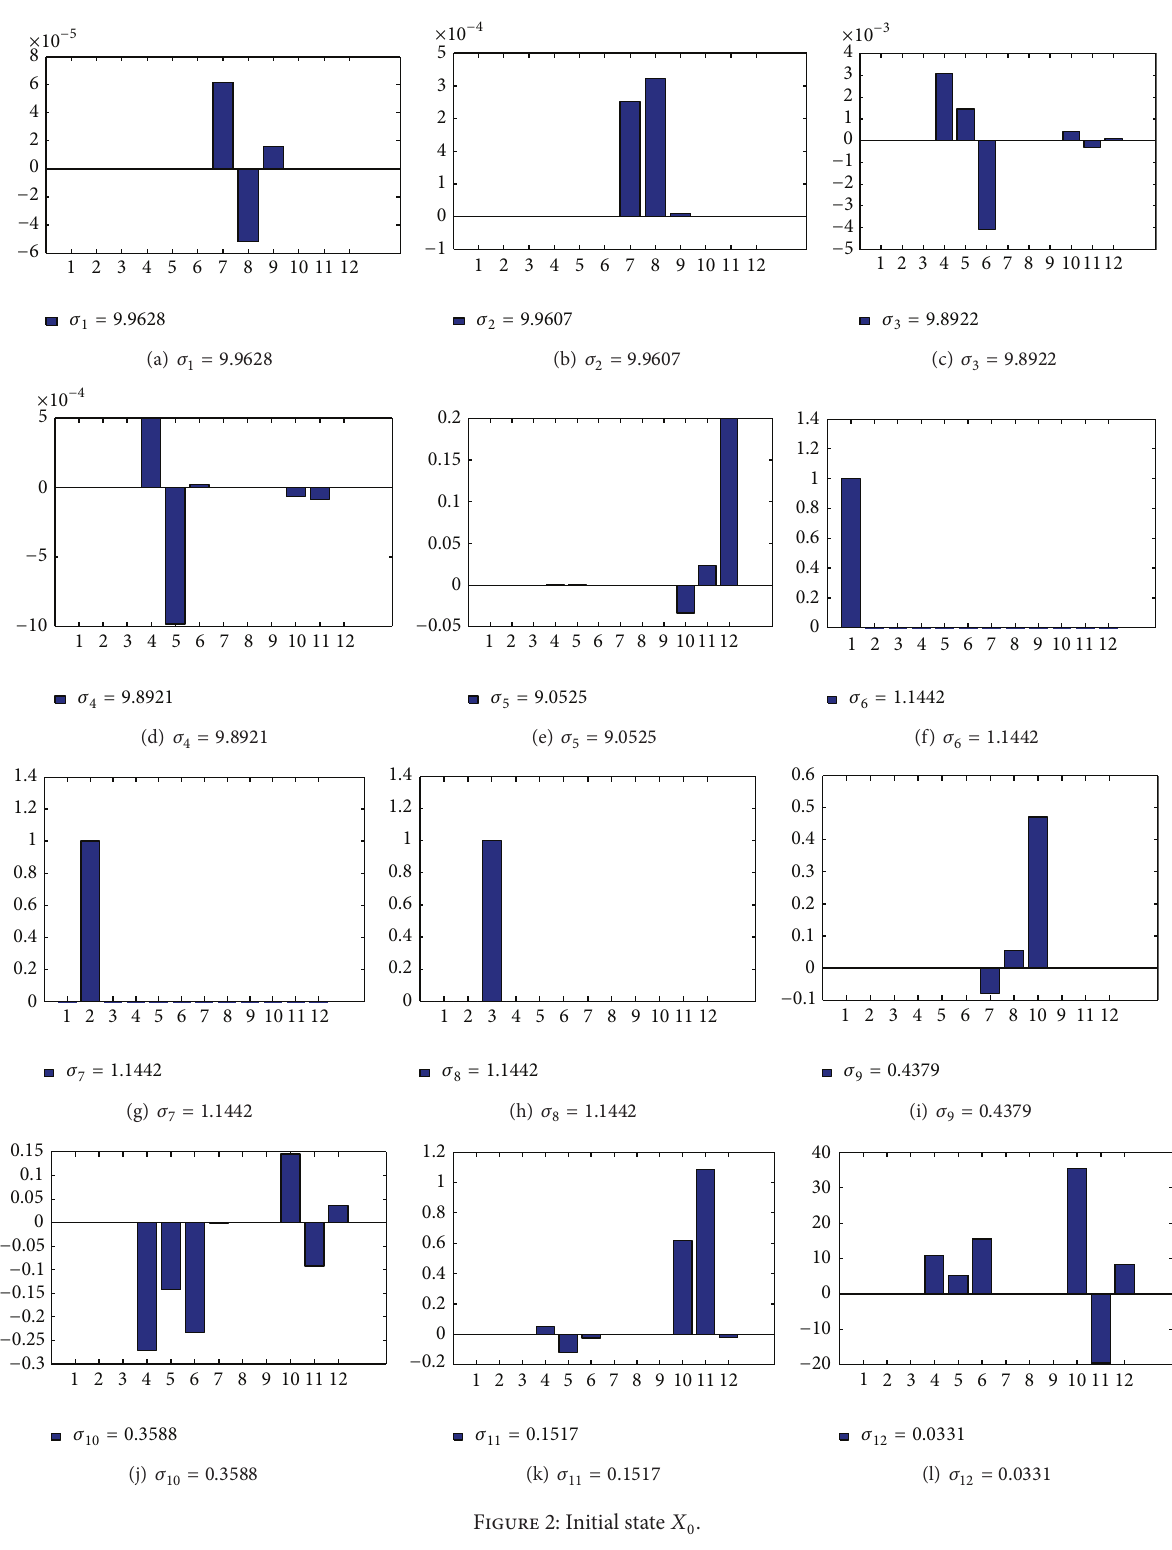
Figure 2: Initial state 𝑋 0